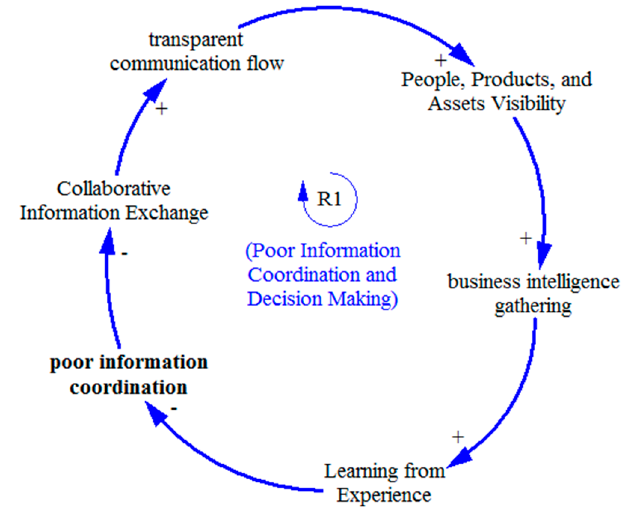
Figure 6. Reinforcing loop R1 (poor information coordination and decision making).